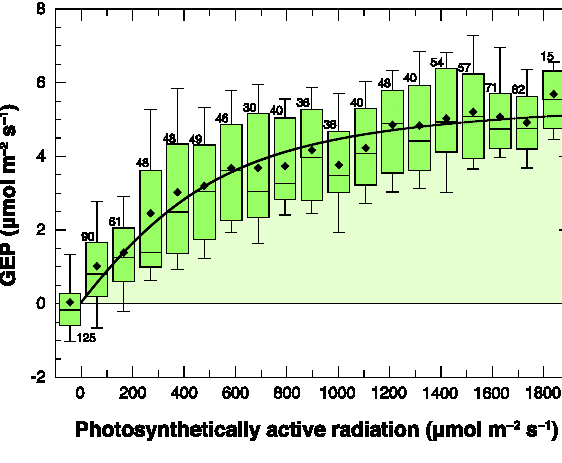
Figure 6. Light response curve determined from all individual 30-minute eddy covariance measurements at the EC flux tower for the period 09 July 2014 to 11 August 2014. The graph shows gross ecosystem photosynthesis (GEP) calculated as the measured average flux at PPFD = 0 (i.e. at night, R = 1.36 µmol m -2 s -1 ) minus the measured daytime net ecosystem exchange (NEE). The black curve is a best fit for Equation (7) with parameters P m = 5.74 µmol m -2 s -1 , φ = 0.0090 and C = 0.7. The night-time u * threshold to determine R was 0.08 m s -1 . The number of valid half-hour measure- ments averaged is indicated above or below each box and the boxes are defined as in Figure 3.